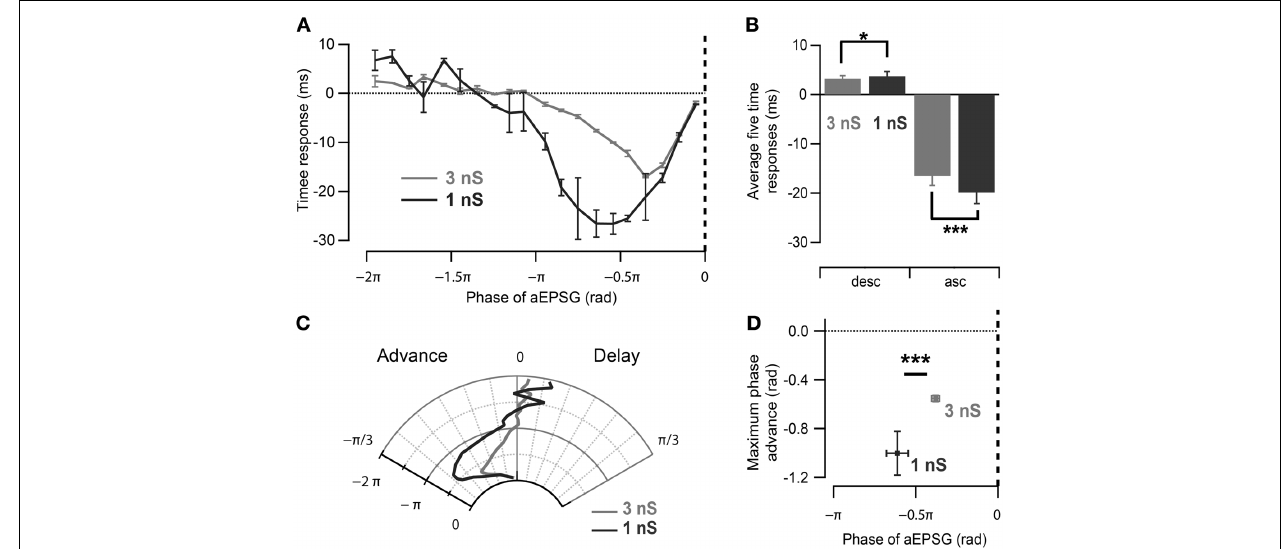
FIGURE 4 | Effect of oscillation strength on the phase response curve. (A) Spike time response curve of CA1 pyramidal neurons measured for strong (3nS) and weak (1nS) induced oscillation. Note differences in the input phase for maximum spike time advance as well as the magnitude of time advance. (B) Spikes have a tendency to be more advanced and delayed by aEPSGs delivered at 0 . 5 π rad of the ascending and descending slope of 1nS than 3nS-induced oscillation respectively. ∗ p < 0 . 05, desc, descending phases.